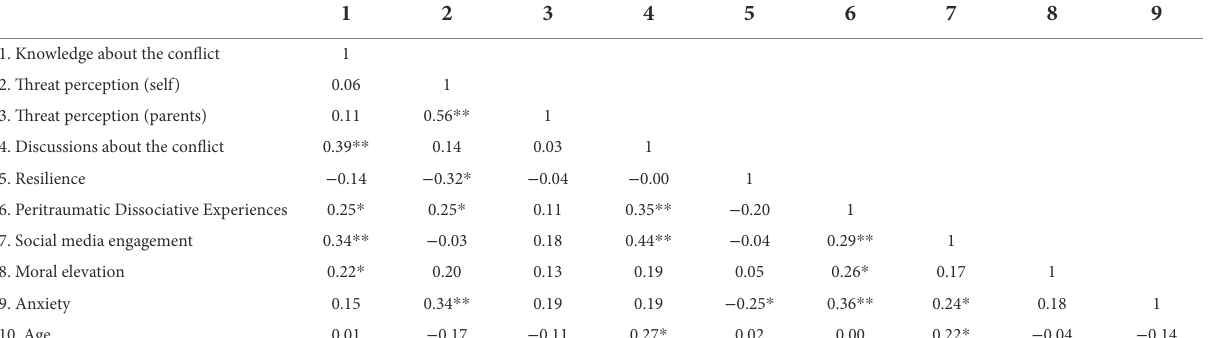
TABLE 3 Associations between the primary variables ( N = 90).